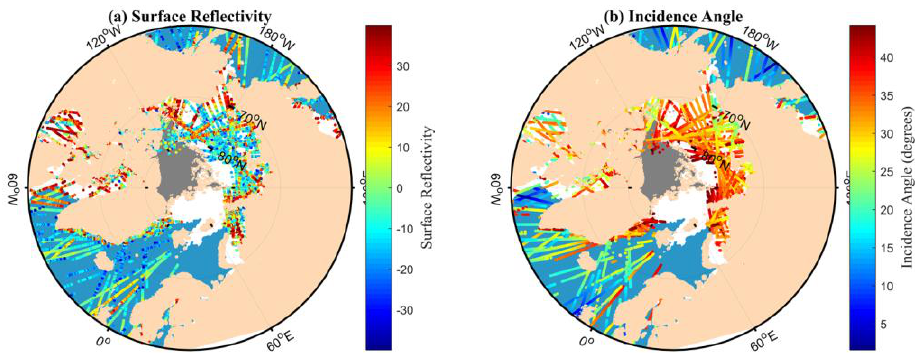
Figure 3. The ( a ) TDS-1 surface reflectivity and corresponding ( b ) incidence angle distribution in Arctic regions in 5 days (from 11 to 15 February 2018). The open water (OW) is described as light blue. The white and gray represent the first-year ice (FYI) and multi-year ice (MYI).